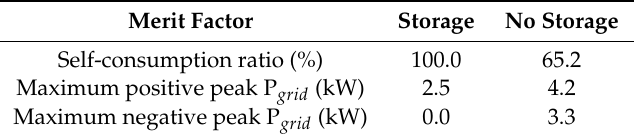
Table 5. Comparison between the full demonstrator and a virtual one without storage.